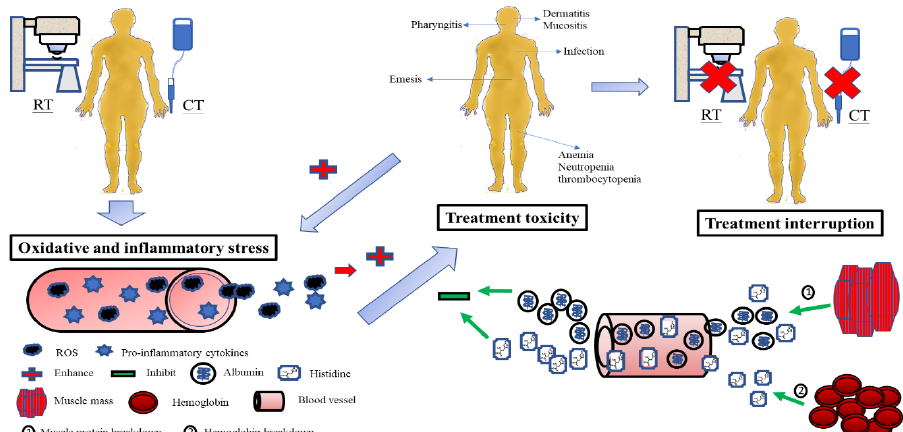
Figure 4. Possible pathogenesis explains the relationship between changes in serum albumin and histidine levels during CCRT, treatment toxicity, and treatment interruption in patients with LAHNSCC undergoing CCRT. The oxidative and inflammatory stress from CCRT consumes serum albumin and histidine. Subsequently, muscle proteolysis and hemoglobin breakdown release albu- min and histidine into the blood to compensate for the serum antioxidant loss and stop the devel- opment of toxicity. If serum antioxidants such as albumin and histidine fail to neutralize oxidative and inflammatory stress, the integrity and function of the mucosa and organs are no more protected from toxicity damage. Treatment interruption inevitably takes place. RT, radiotherapy; CT, chemo- therapy; CCRT, concurrent chemoradiotherapy; LAHNSCC, locally advanced head and neck squa- mous-cell carcinoma. The strengths of the present study are its homogeneous patient population treated with the standard CCRT protocol under the provision of recommended calories and pro- tein over the treatment course, along with the simultaneous analysis of all confounding covariates. However, further research is needed for more detailed understanding. First, because patients with HNC undergoing CCRT require over 55,000 calories to complete the treatment course [114], the albumin and histidine released from the muscle mass and hemoglobin may be metabolized for energy fuel. For instance, histidine can be converted to glutamate, which can enter the glutamate–ornithine–proline pathway or the tricarbox- ylic acid cycle to produce energy [49]. In the present study, the mean BW was approxi- mately 60 kg, and the average treatment duration was 42 days. Under the mandatory pro- vision of at least 25 kcal/kg/day of energy, the patient would receive more than 60,000 calories throughout the entire CCRT course. The conversion of proteins and histidine to energy is trivial. Second, the changes in serum levels of albumin reflect the dynamic state between albumin synthesis and catabolism, including degradation and clearance in re- sponse to stress, inflammation, and diseases [115]. Fearon et al. demonstrated that the albumin synthesis rate is not changed in cancer patients even with low serum albumin concentrations [116]. Our results reported no grade 3/4 diarrhea toxicity, and there were no significant differences in interval changes regarding liver function, renal clearance (ΔALT, Δtotal bilirubin, and ΔeGFR), or the intake of calories, carbohydrates, proteins, and fat between the interruption and no-interruption groups. It is thus less likely that insufficient synthesis, increased gastrointestinal loss, and renal clearance could affect the interval changes in albumin levels during CCRT and lead to the resultant treatment inter- ruption. Third, the decrease in treatment-interval serum histidine levels could be a conse- quence of enhanced histidine catabolism [117] or its increased accumulation in the muscle,